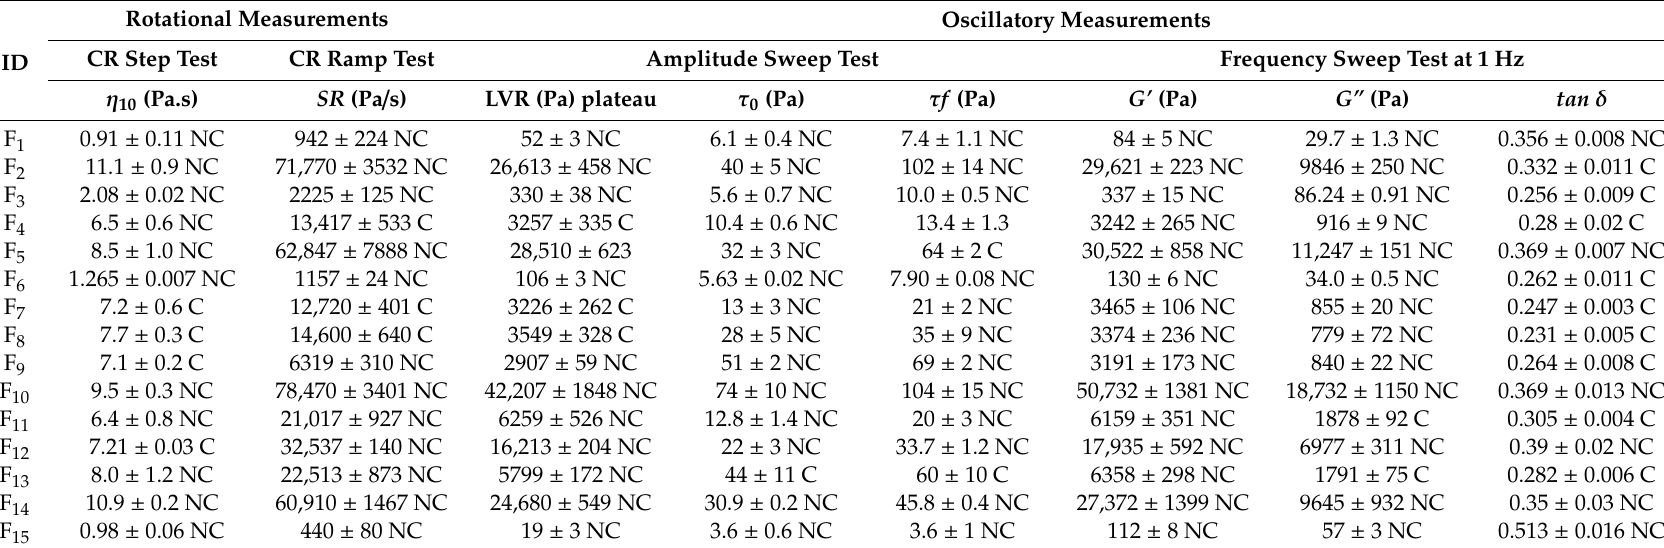
Table 6. E ff ect of independent variables on cream rheological profile. Data are expressed as mean ± SD ( n =